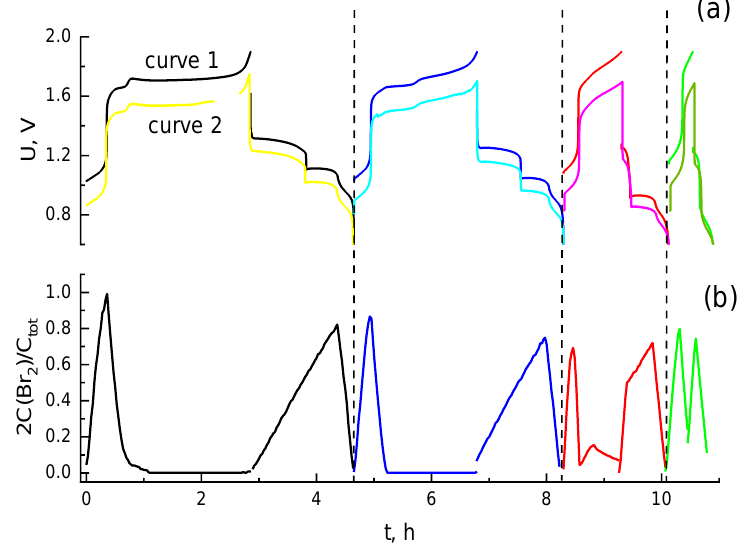
Figure 6. Charge—discharge (curve 1) and polarization (curve 2) curves of the positive electrode of a hydrogen-bromate flow battery ( a ), and a graph representing the variation in the fraction of Br atoms which are inside Br 2 molecules at a time moment, t, which is equal to the ratio of the number of bromine atoms inside Br 2 molecules to the initial content of bromine atoms in the system, i.e., 2 C(Br 2 )/C 0 (Br − ) where C(i) is the molar concentration of species i; ( b ). Charging stage (Br − oxidation): galvanostatic mode, current density: 0.075 A/cm 2 , initial composition of the catholyte supplied to the positive electrode: 0.3 M HBr + 3 M H 2 SO 4 , pumping rate: 30 mL/min, the negative electrode is open to the atmosphere. Discharge stage (BrO 3 − reduction): galvanostatic mode, current density dur- ing discharge: − 0.075 A/cm 2 , initial composition of the catholyte supplied to the positive electrode: solution at the end of the charge stage, hydrogen is supplied to the negative electrode at a rate of 10 mL/min.